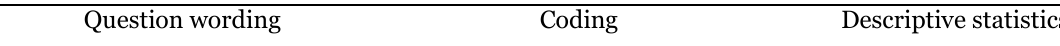
Survey Question Wording and Descriptive